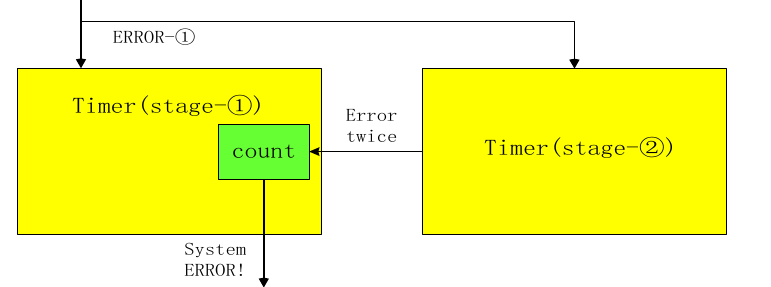
Figure 17. Fatal error abnormal monitoring. The module is embedded between 1 to 5 stages of the pipeline and is placed at every two stages of the pipeline to monitor whether the errors between two adjacent decoding modules occur repeatedly. If the interval period is one cycle, the count will increase by 1, and a fatal information alarm will be sent after the count reaches the threshold. Then, the system generates a system ERROR.